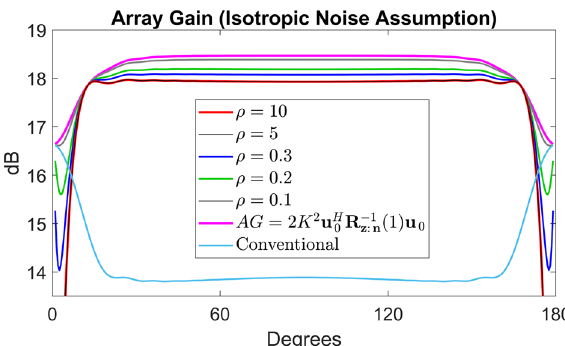
Fig. 7 Theoretical array gain obtained for a generic triplet line array using different values of the ratio ρ = σ i /σ n and comparison with the array gain of the conventional